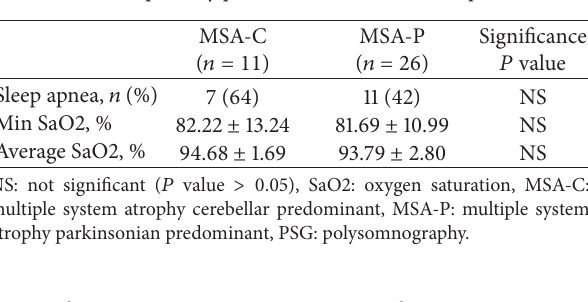
Table 4: Respiratory parameters at PSG in MSA